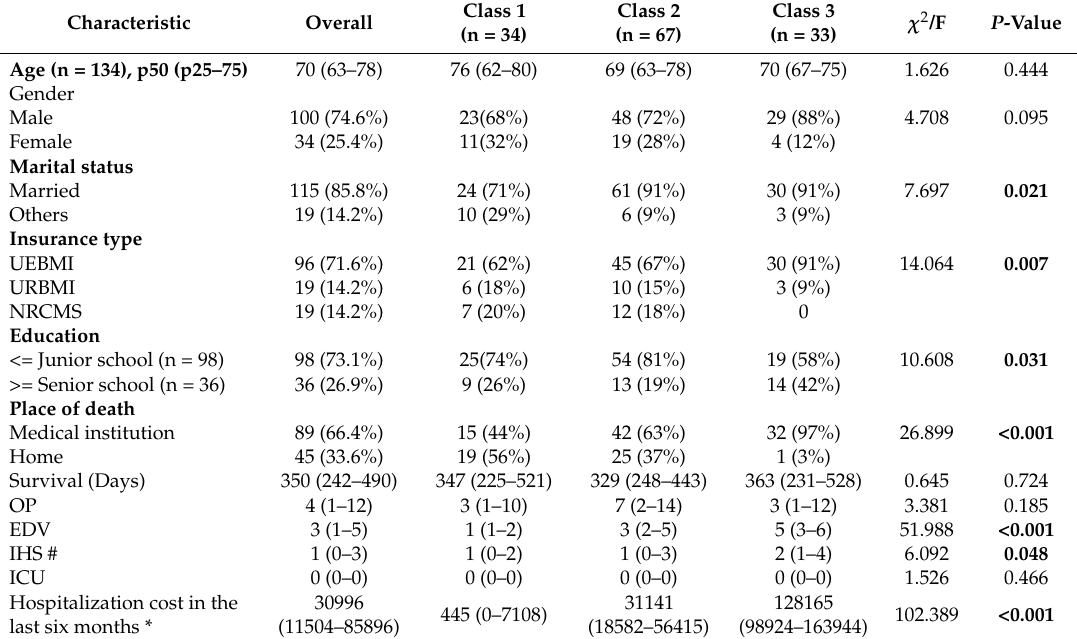
Table 1. Comparison of demographic characteristic, EOL care utilization, and hospitalization cost.